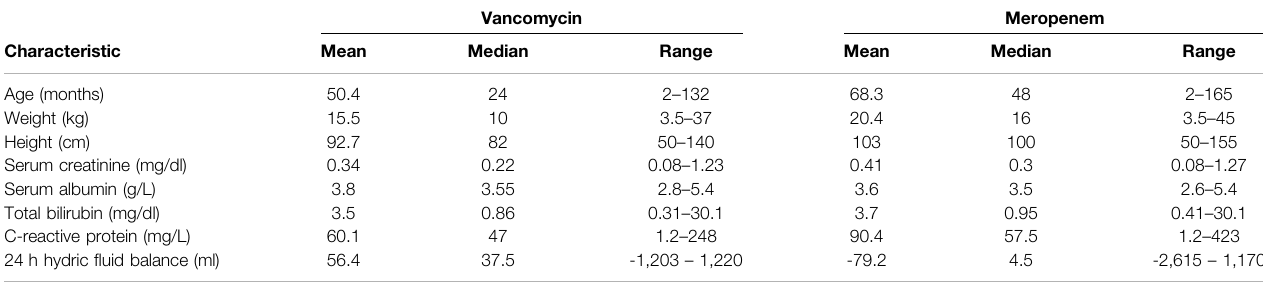
TABLE 2 | Patient characteristics.